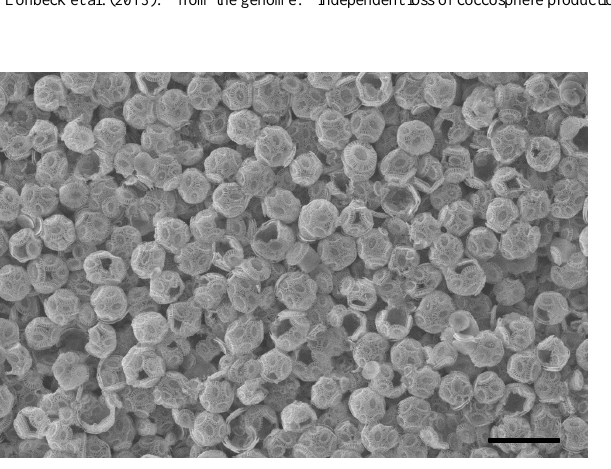
Figure 3 Figure 3. Scanning electron micrograph of a mixed Emiliania hux- leyi culture prior to single cell isolation originating from D366 sta- tion 5 in the North Sea. Bar = 5µm.